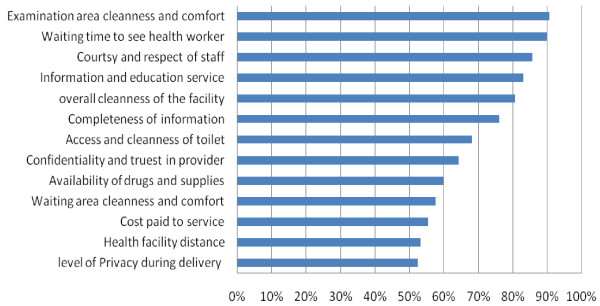
Major dimensions of care and average satisfaction scores by postnatal mothers delivered in 3 Referral hospitals in Amhara Region, Ethiopia.